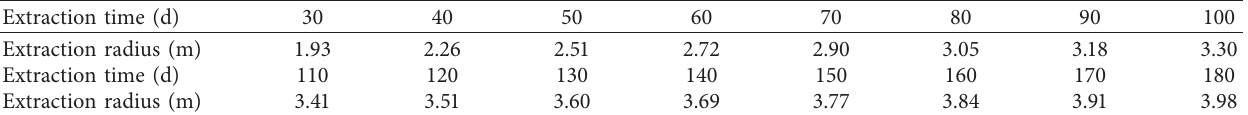
Figure 10: Fitting curve of the extraction radius with time in No. 24 drilling field. Table 1: Extraction radius at different extraction